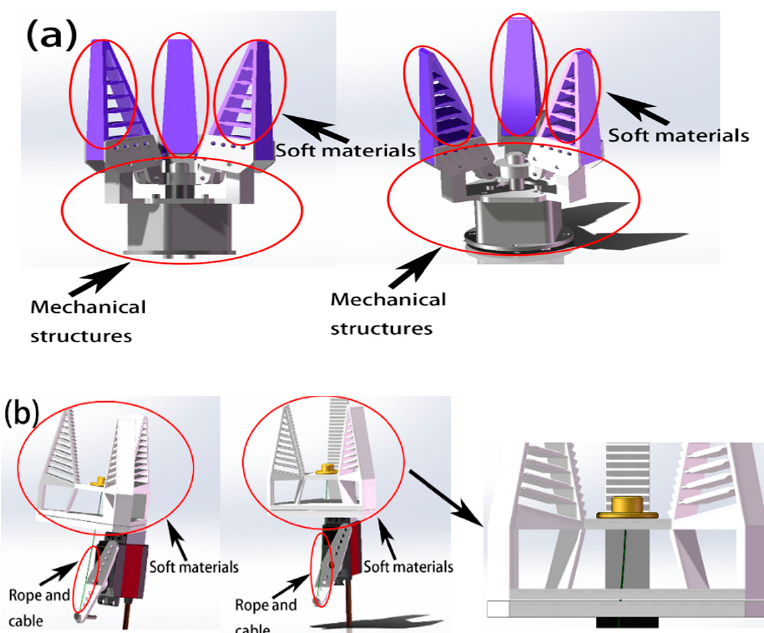
Figure 1. Comparison of a common commercially available Fin Ray effect inspired soft gripper with the soft gripper proposed in this paper. ( a ) shows a common commercially available soft adaptive gripper. ( b ) shows the soft gripper designed in this